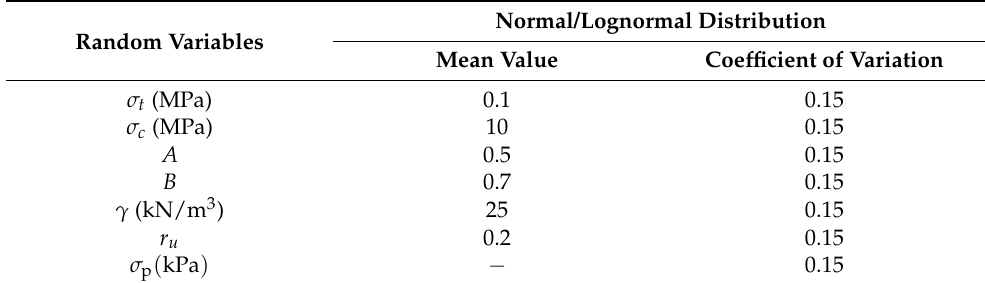
Table 4. Statistical values of random variables used in the analysis .